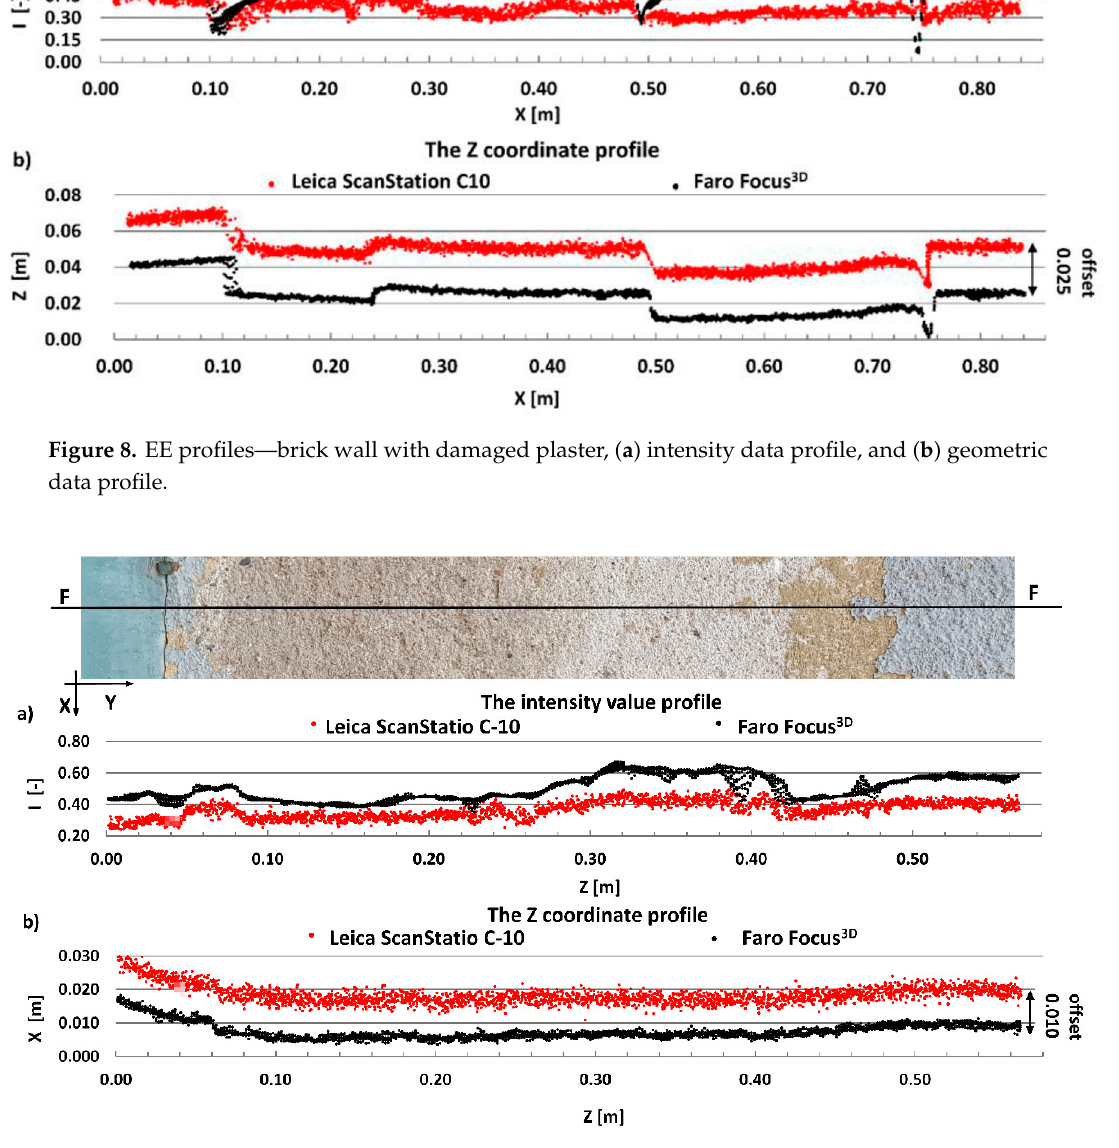
Figure9. FFprofiles—weatheredpartofthewall: ( a )intensitydataprofileand( b Figure 9. FF profiles—weathered part of the wall: ( a ) intensity data profile and ( b ) geometric data profile.